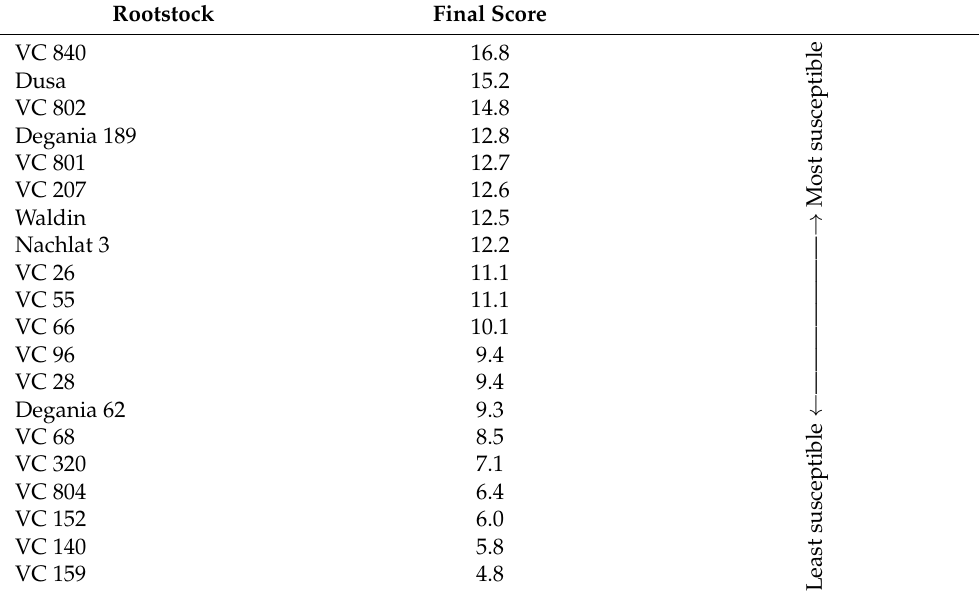
Table 3. Salt susceptibility rating of avocado rootstocks under EC 1.4–1.5 dS/m.